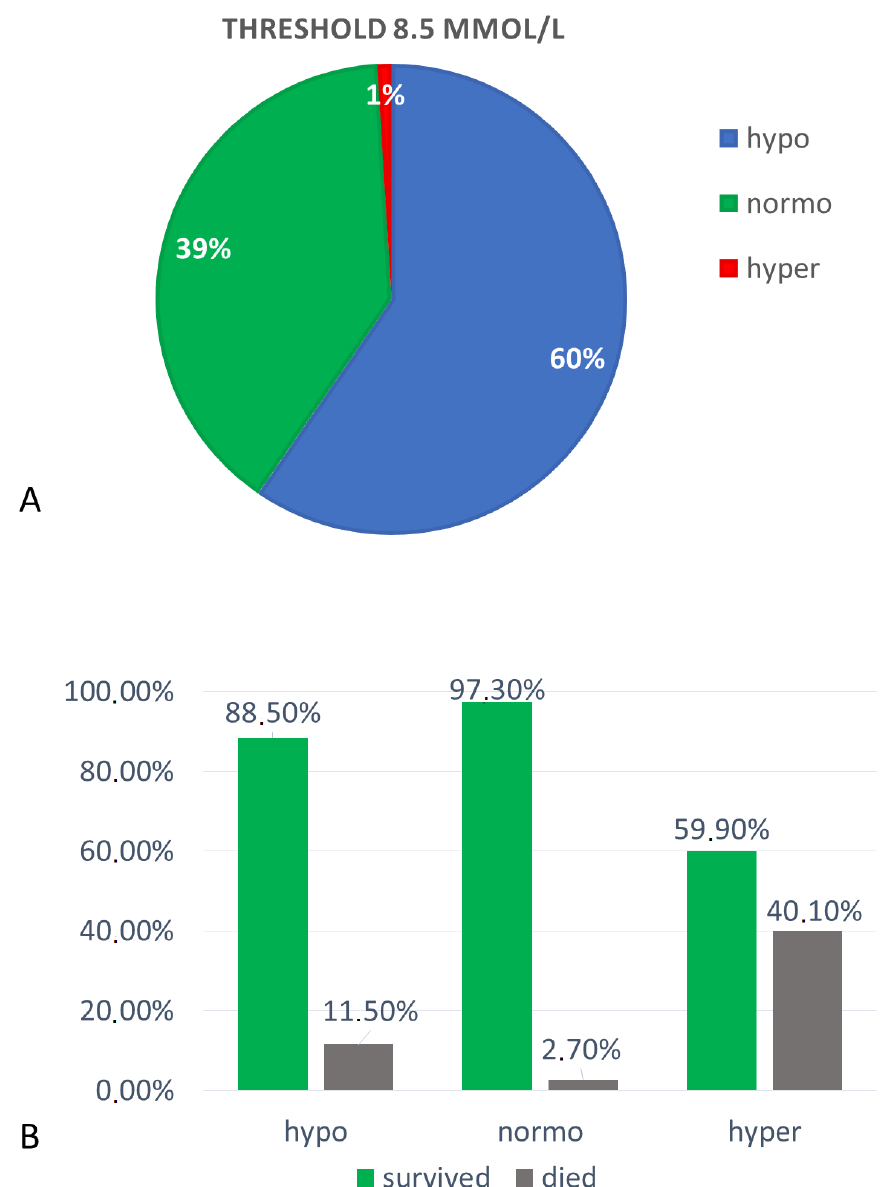
Figure 3. ( A ) Percentages of subjects assigned to hypo-, normo- and hyper-magnesemia groups at reference values of 0.85–1.2 mmol / L, and ( B ) in-hospital mortality ratio among separated groups. The difference between death ratio is statistically significant (Chi-square test), p < 0.0001.